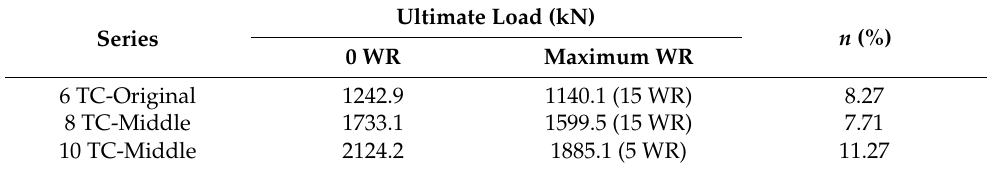
Figure 24. Axial compressive load behavior of different models. Table 4. Comparisons of ultimate load-bearing capacity of FEM.